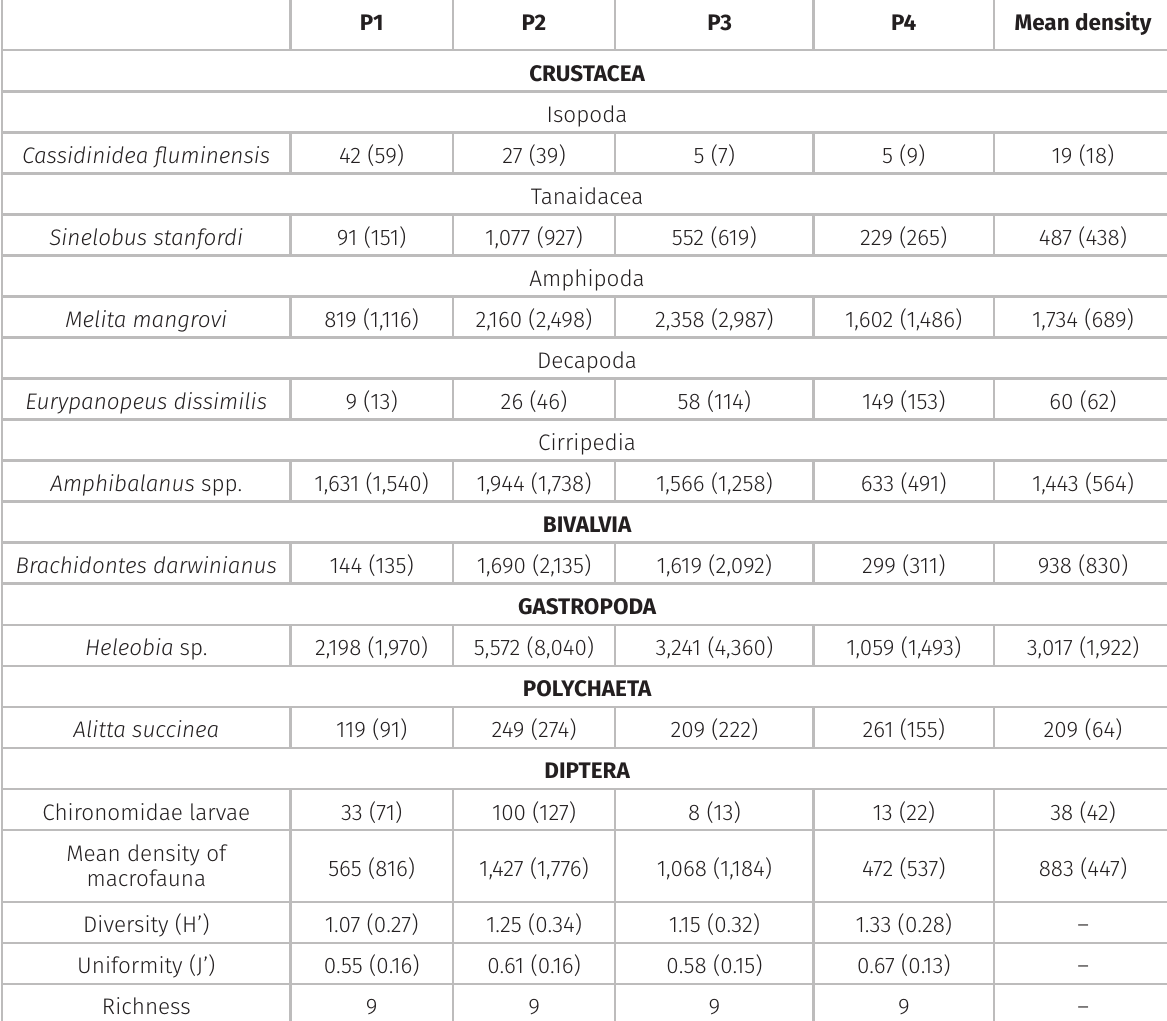
Table I. Mean values of density of species and density of total macrofauna per sampling site, diversity (H’), uniformity (J’) and values of richness. Numbers inside parentheses indicate standard deviations (±